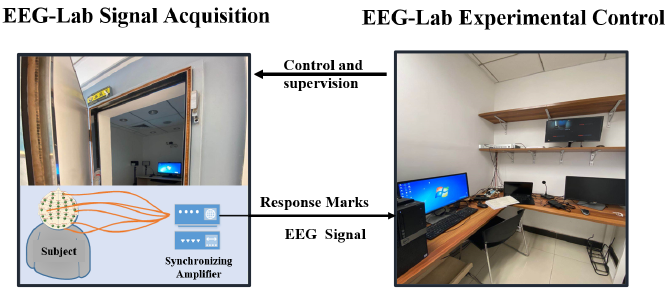
Figure 2. EEG experiment